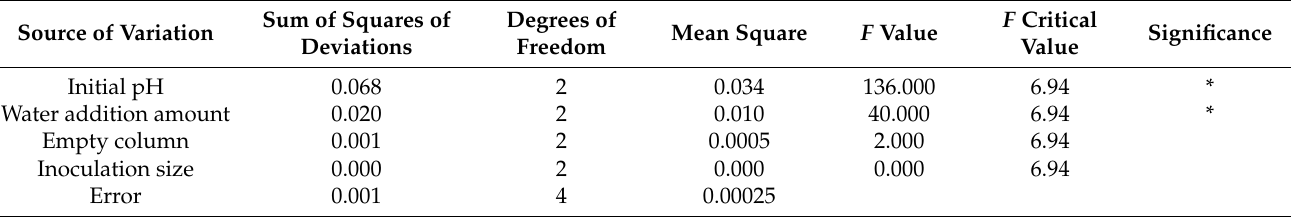
Table 8. Variance analysis of Pediococcus acidilactici fermentation